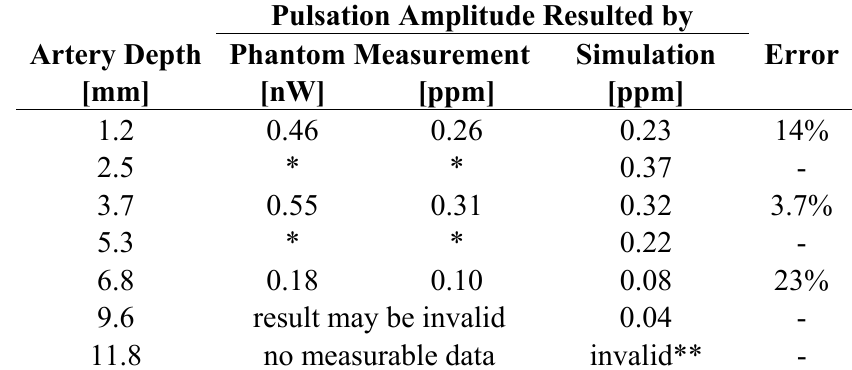
Table 1. Results of measurements (n > 20 in every case) performed on the phantom are shown in the second and third column. The fourth column shows the results of the